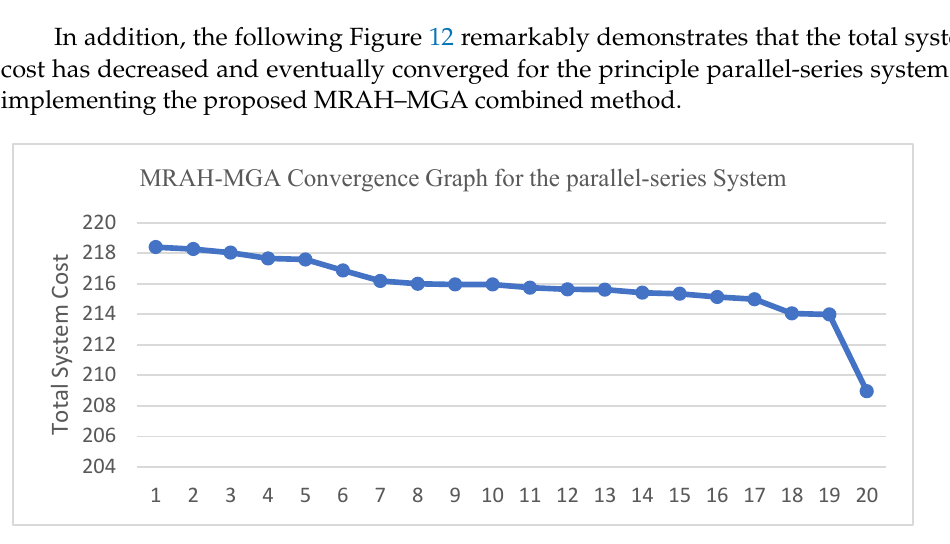
Figure 12. The convergence graph of the parallel-series system by implementing the MRAH-MGA combined method.